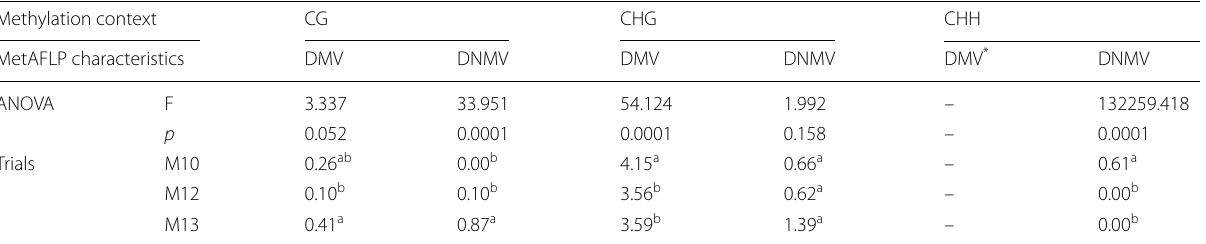
The M10, M12, and M13 state for trials, whereas upper case letters reflect Tukey’s HSD grouping. *ANOVA not available for 0 value